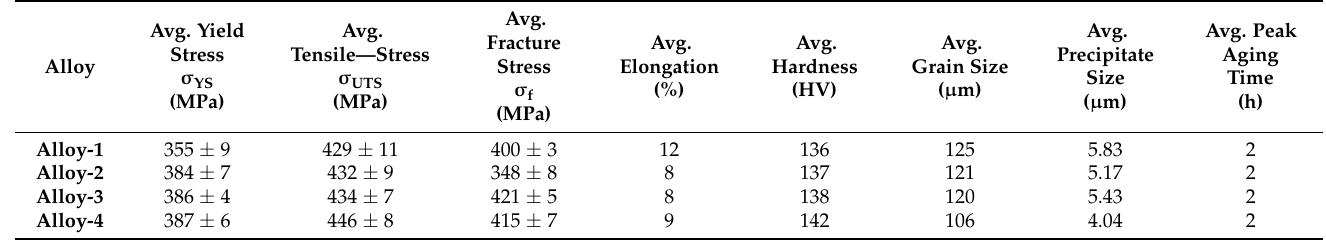
Table 3. Comparative relationship of mechanical properties and the corresponding microstructural features at peak aged